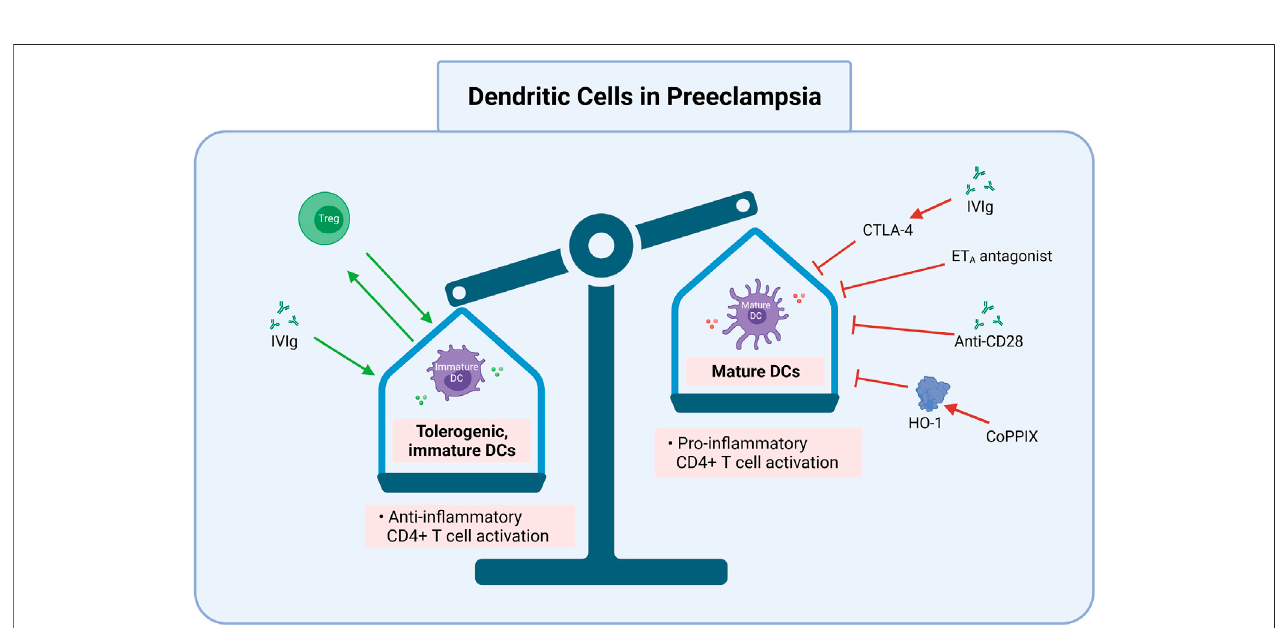
FIGURE 4 | DC cells maturation and function may be targeted in preeclampsia. Inhibition of mature CDs and induction of tolerogenic, immature DCs is one promisingrouteforpreeclampsiatreatmentandprevention.TargetstoachievethisincludeexogenousTregtransfer,IVIgstopromotetolerogenicDCs(e.g.,viaCTLA-4), CoPPIXinducedHO-1activation,andET A antagonists.IVIgviaCTLA-4,anti-CD28,ET A antagonists,andCoPPIXviaHO-1inhibitmatureDCfunction,whichcanbepro- in fl ammatorytoCD4+Tcells.Treg,regulatoryTcell;DC,dendriticcell;CTLA-4,cytotoxicTlymphocyte-associatedantigen-4;IVIg,intravenousimmunoglobulinG; ET A , endothelin-1 receptor A; anti, antibody; CoPPIX, cobalt protoporphyrin; HO-1, heme oxygenase 1. Created with https://biorender.com.